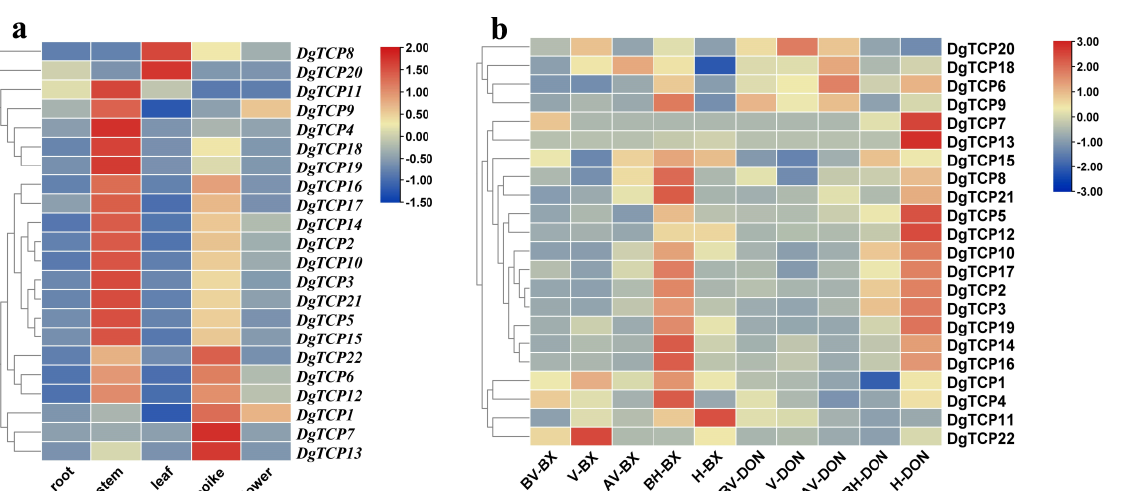
Figure 7. Cis-elements in the promoter regions of the DgTCP genes. ( a ) The cis-elements in the DgTCP promoter regions. ( b ) The number of DgTCPs and corresponding cis-elements (red line) and the total number of cis-elements in the DgTCP gene family (black box). ( c ) The number of cis-ele- ments (from the promoter regions of each DgTCP) associated with plant growth and development, phytohormone, and stress responses.